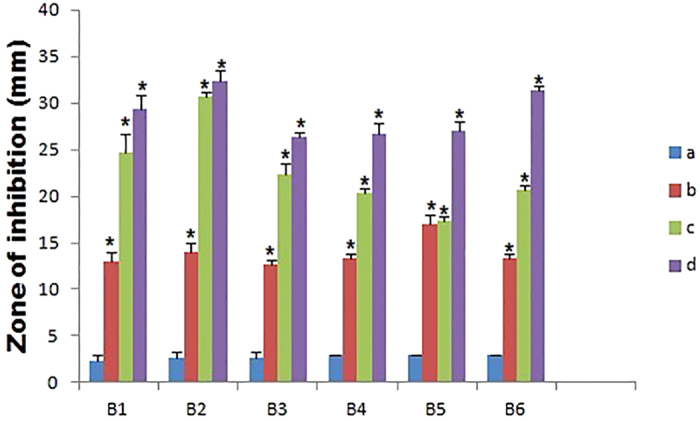
The Column chart showing the ZOI measurement of SNPs, topical antibiotic and combinations against S. aureus.B1: Cefazolin; B2: Mupirocin; B3: Gentamycin; B4: Neomycin; B5: Tetracycline; B6: Vancomycin. a: Control; b: SNP; c: Topical antibiotic; d: SNP + Topical antibiotic. Values are expressed as means (n = 3), and error bars represent standard deviations. Asterisks (*) indicate a statistical significant difference (P < 0.05) between the control and the treatments.